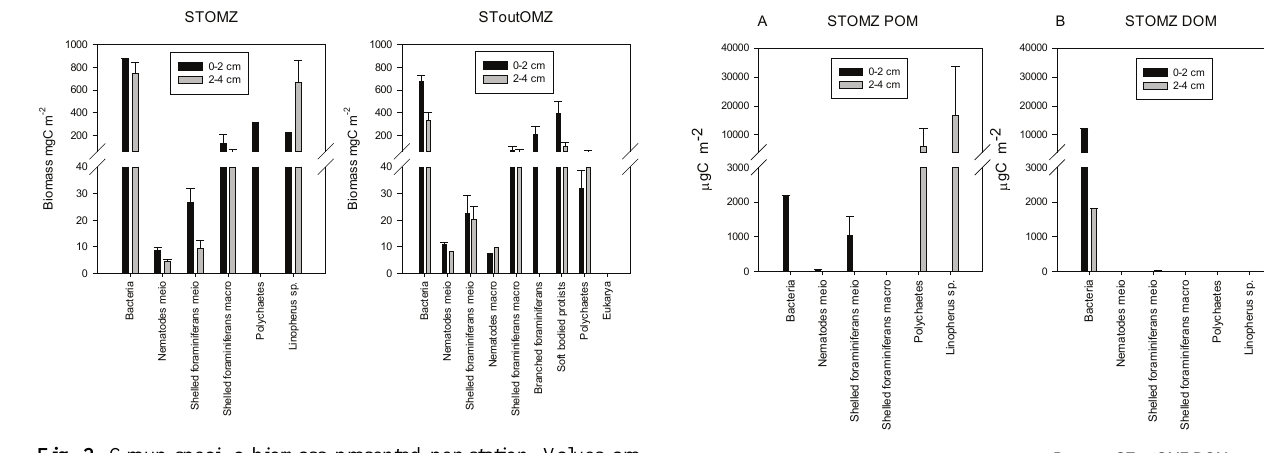
Fig. 2. Group-specific biomass presented per station. Values are averages of all cores, background and incubated ones, both treat- ments, to better account for heterogeneity. “Polychaetes” regroup all polychaete species other than Linopherus sp., “Eukarya” regroup all other faunal groups besides nematodes, foraminifera and poly- chaetes, for which no determination was done.